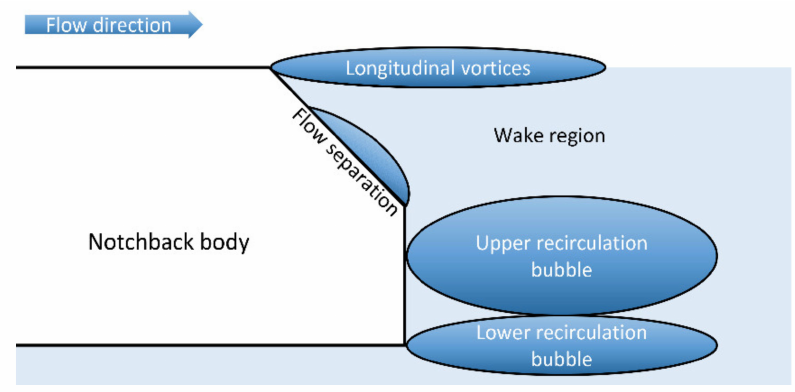
Figure 3. Generated vortices behind a notchback vehicle (based on Zhang et al.